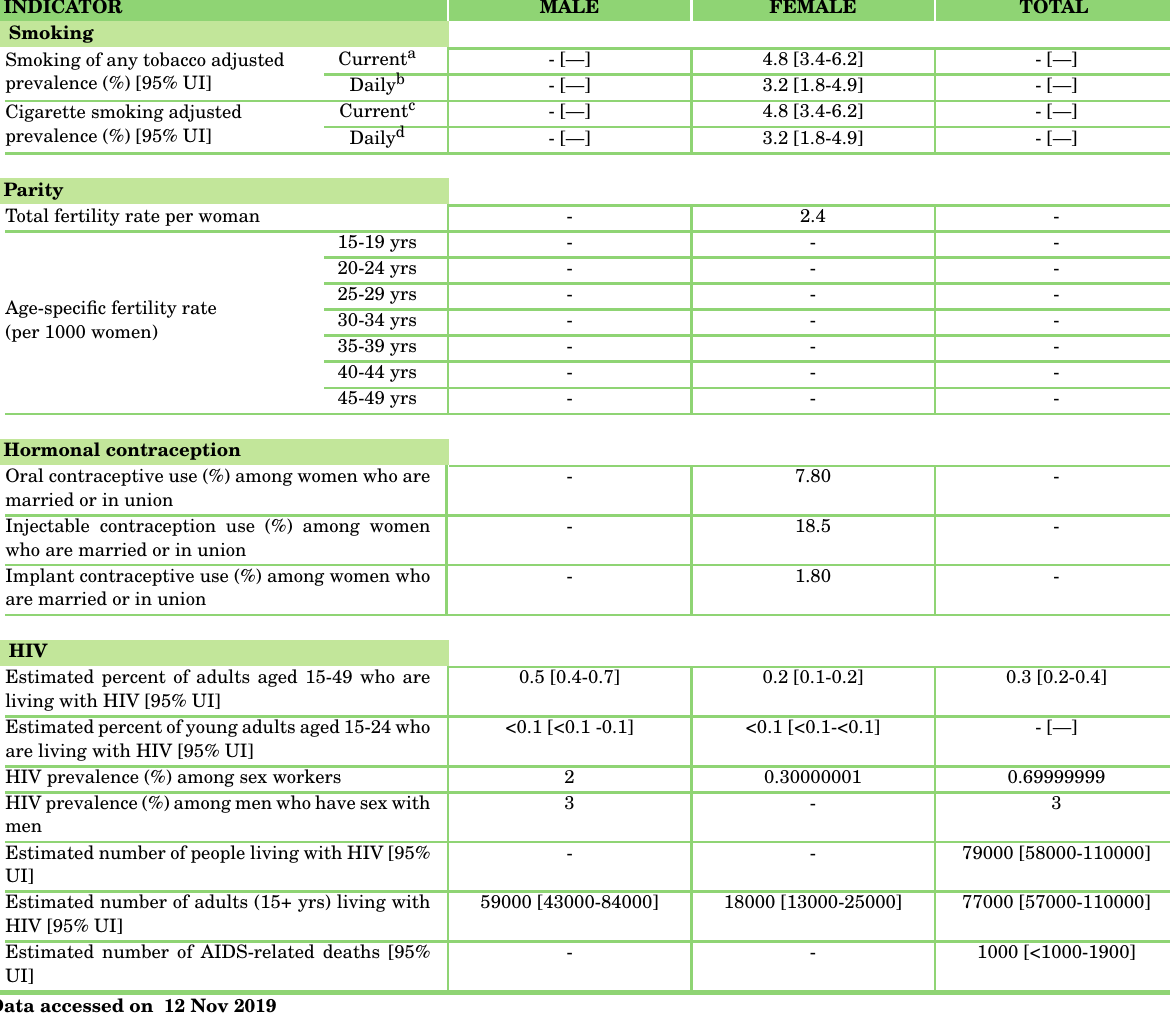
Table 39: Factors contributing to cervical carcinogenesis (cofactors) in